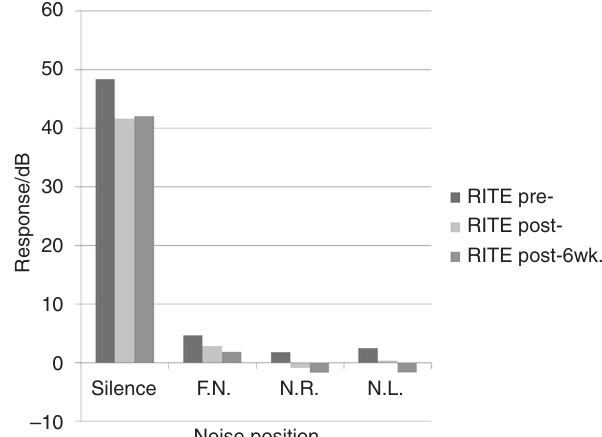
Responses in group 1 obtained with the application of the hearing in noise test (HINT) at three times: without hear- ing aid (HA), with HA, and six weeks after the fitting ( n = 10).